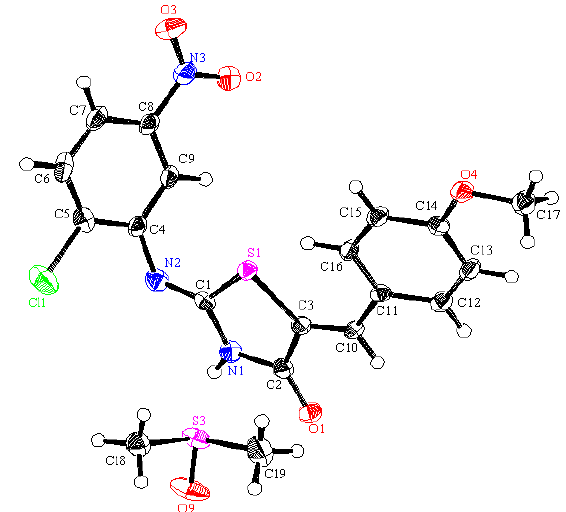
Figure 5. ORTEP plot of the X-ray crystallographic data determined for 7c containing a DMSO molecule. Crystallographic data have been deposited with the Cambridge Crystallographic Data Centre as supplementary publication number CCDC 875772